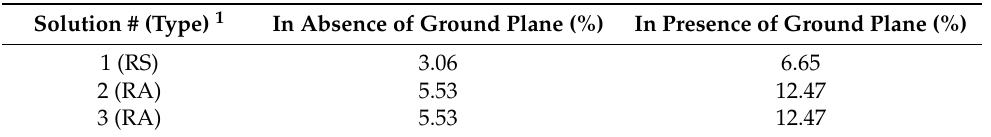
Table 5. Maximum rate of change among the elements of the resonant linear array structure in comparison with the half-wavelength design for the Real Pattern Case (RPC) of 10 elements.